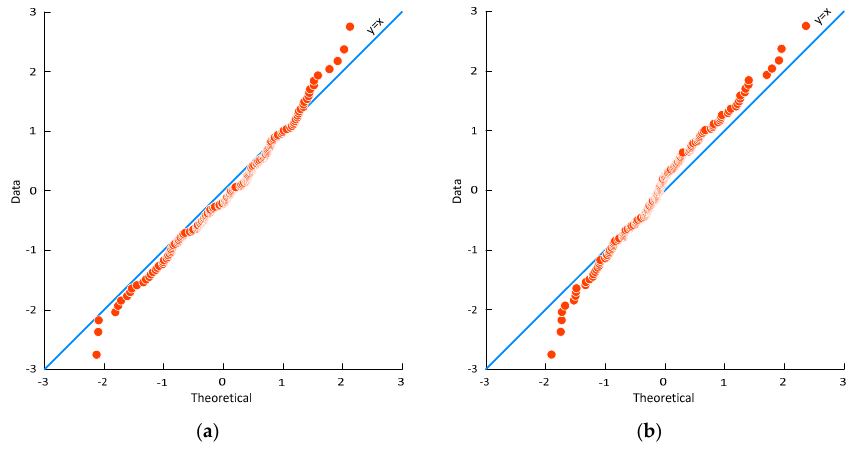
Figure 16. Q-Q plot, dataset 3. ( a ) T = 0.50 s; ( b ) T = 1.00 s.